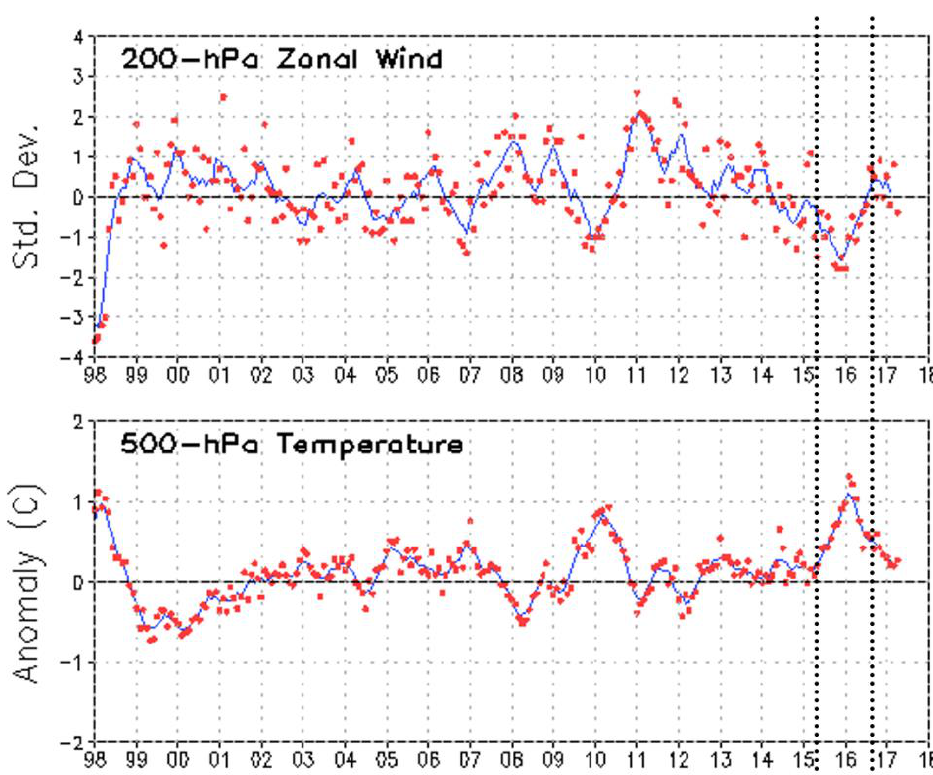
Figure 7. Variation in the surface wind direction and tropospheric temperatures of the central Pacific Ocean during the 2015–2016 ENSO. The 2015–2016 ENSO period is bracketed by the black dotted lines. The 200-hPa zonal winds are winds at the sea surface. The 500—hPa temperature is the temperature of the Troposphere. The strong negative anomaly in the wind indicates a strong westerly wind direction. Plots courtesy of the U.S. National Weather Service Climate Prediction Center.